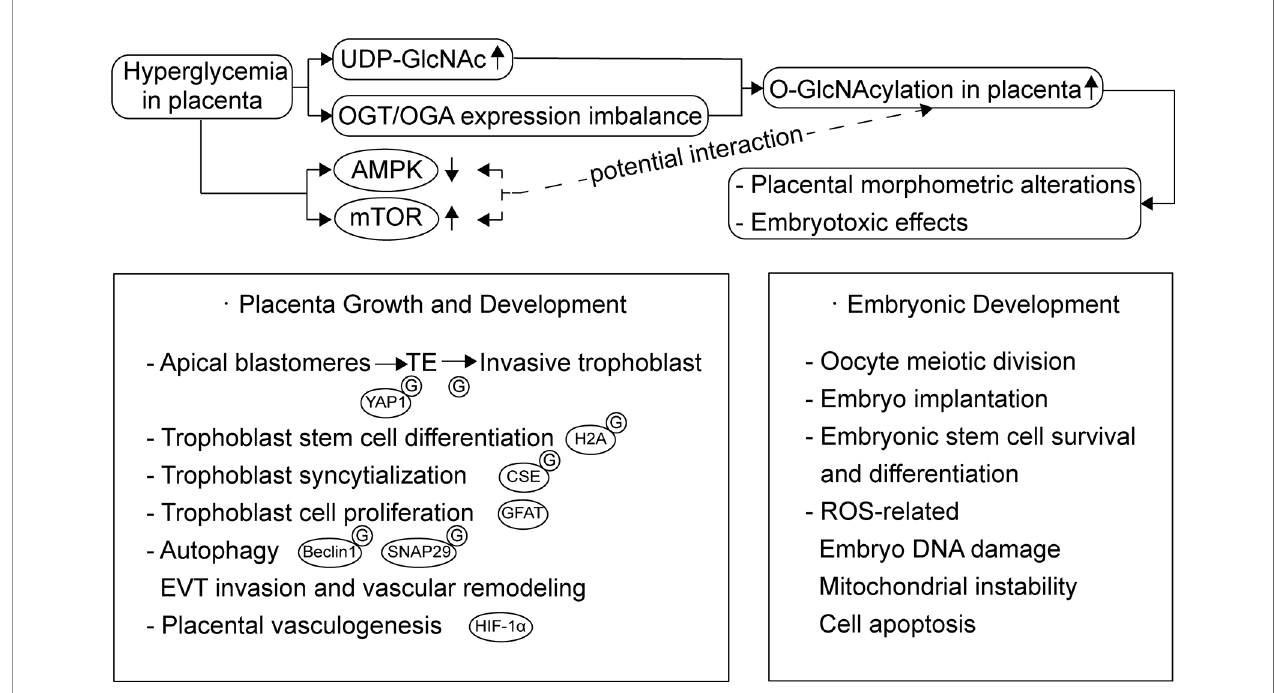
FIGURE 2 | Overview of the function of O-GlcNAcylation during placentation and placental development and O-GlcNAcylation dysregulation in placenta exposed to HIP. Besides embryonic development, O-GlcNAcylation also plays a role through all stages of placental development, including trophoblast cell proliferation, differentiation, syncytialization and autophagy. Hyperglycemia increases the glucose fl ux through HBP and affects placental OGA expression, which leads to increased O-GlcNAcylation accumulation in placenta. These changes may result in placental morphometric alterations and embryotoxic effects. mTOR and AMPK activity altered in HIP and their potential interaction with O-GlcNAcylation needs further